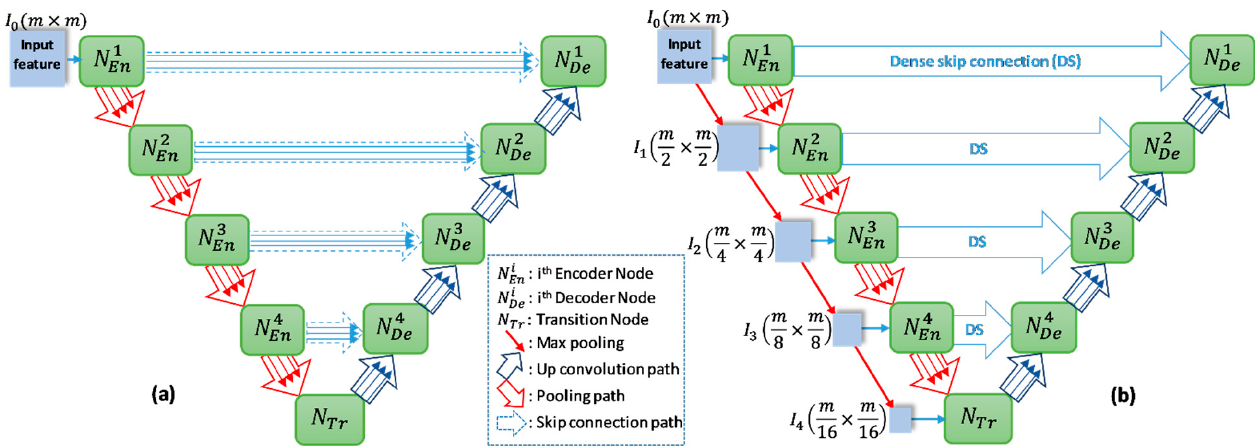
Figure 2. The network structures of ( a ) T-Unet and ( b ) TMD-Unet. There are five input features in the TMD-Unet model. “ mxm ” indicates the 2D size of the input features.